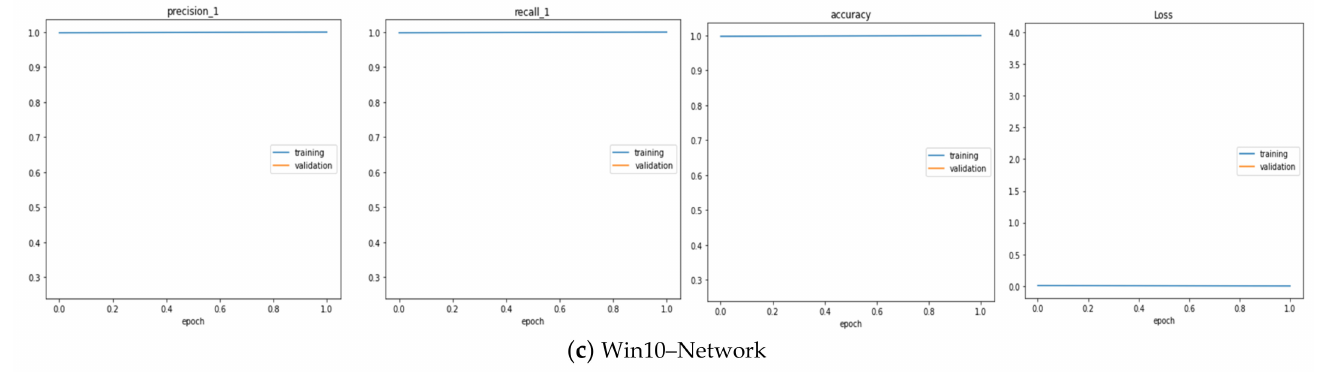
Figure 8. ( a – c ) The training and validation accuracy, F1-score, loss, recall, and precision on the ToN-IoT dataset after training with the Inception Time model.